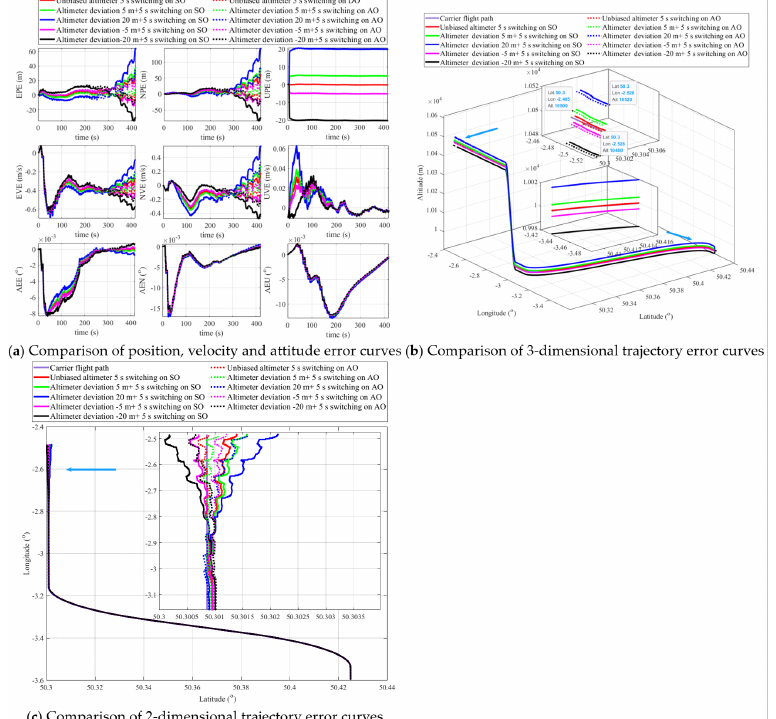
Figure 9. Comparison of navigation and positioning of different altimeter deviation scenarios under 5 s switching time.